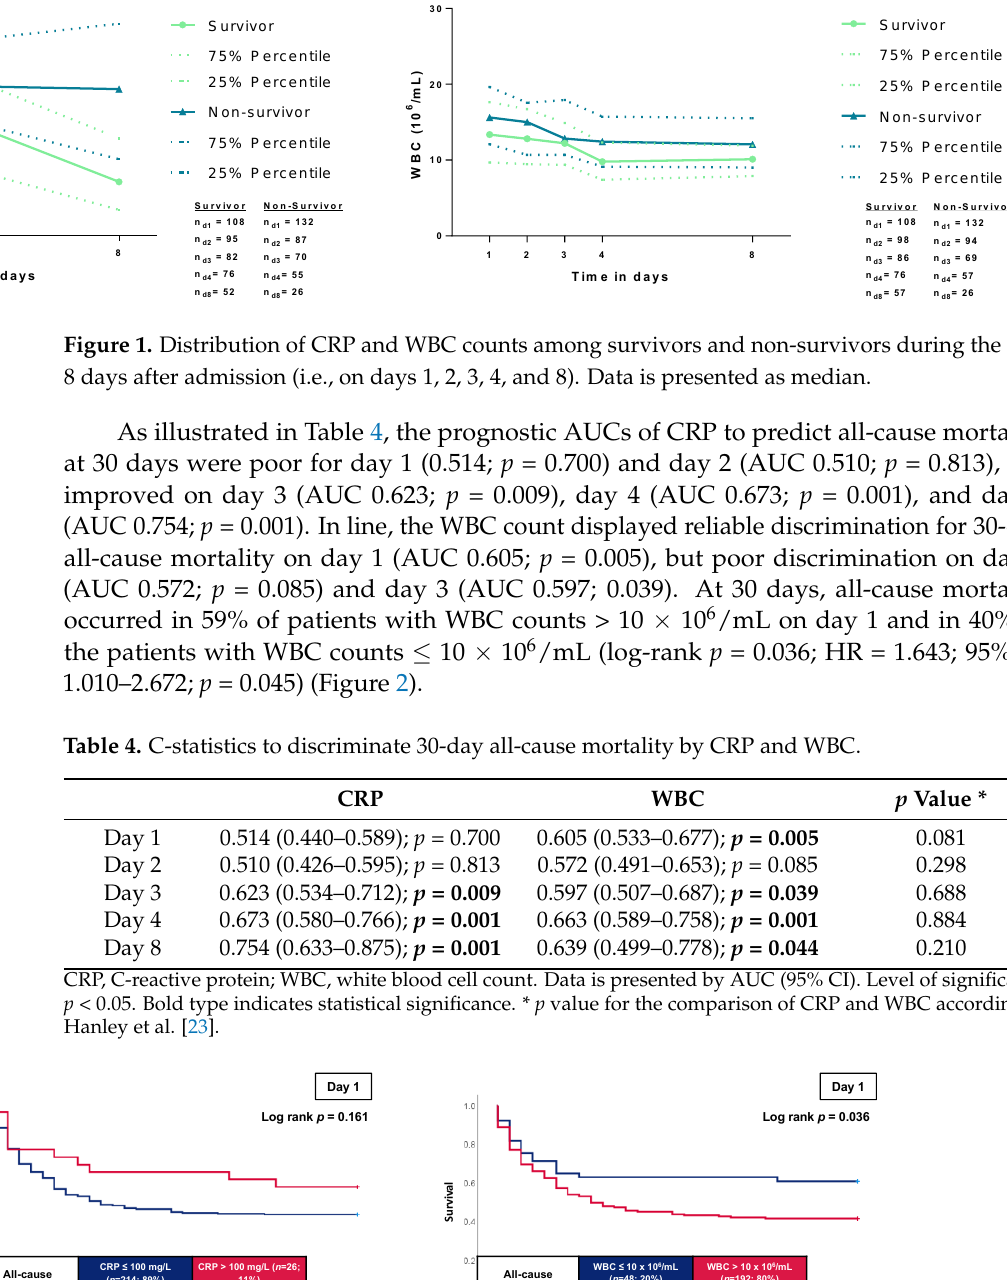
D a y s o f s u r v i v a l 104 Figure 2. Kaplan–Meier curves of CRP and WBC count on day 1 for all-cause mortality at 30 days. Figure 2. Kaplan – Meier curves of CRP and WBC count on day 1 for all-cause mortality at 30 days. In contrast, CRP levels on day 1 were not associated with 30-day all-cause mortality (log-rank p = 0.161). However, on day 3, an increased 30-day all-cause mortality rate was observed in patients with CRP > 100 mg/L compared to patients with CRP levels of less or equal 100 mg/L (56% vs. 37%; log-rank p = 0.023; HR = 1.702; 95% CI 1.060–2.735; p = 0.028) (Figure